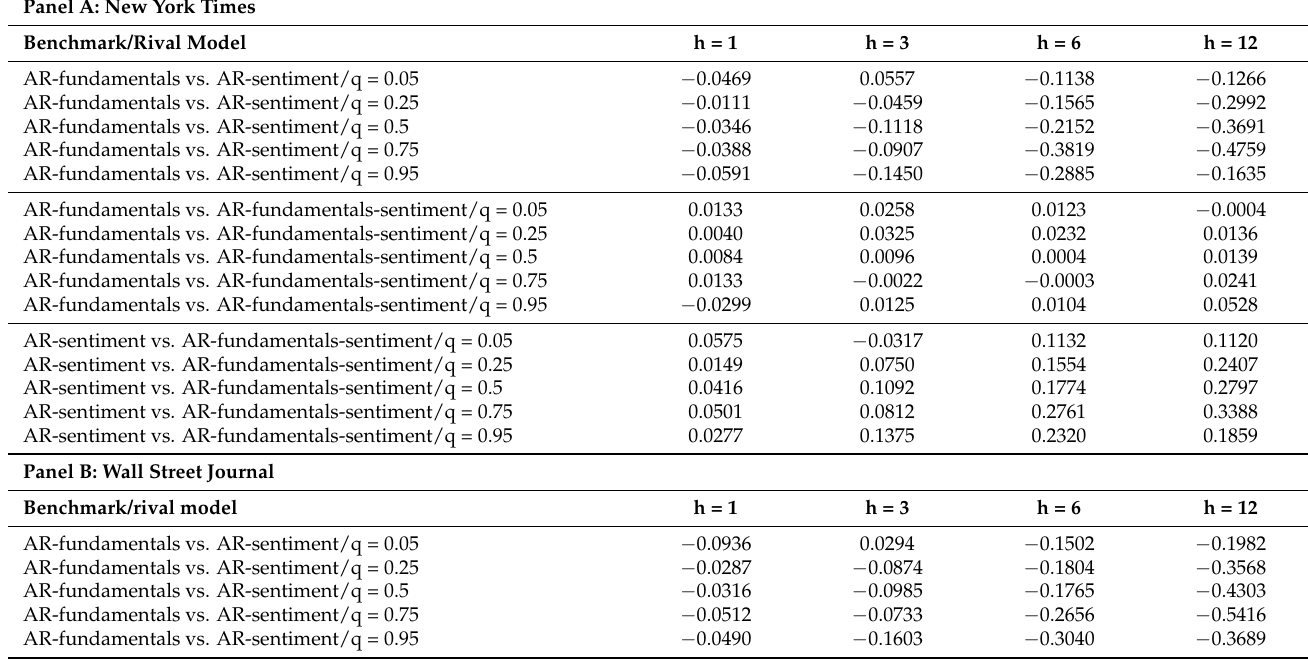
Table A2. Sentiment vs. news (sample starts in